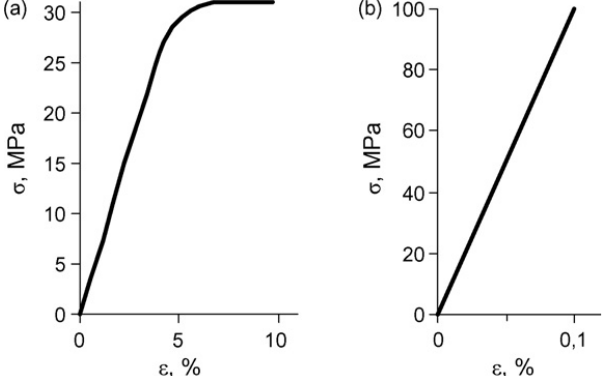
Figure 7. Elongation curves for the Y at ambient (a) and in liquid nitrogen (b) temperatures. Ceramic/binder weight